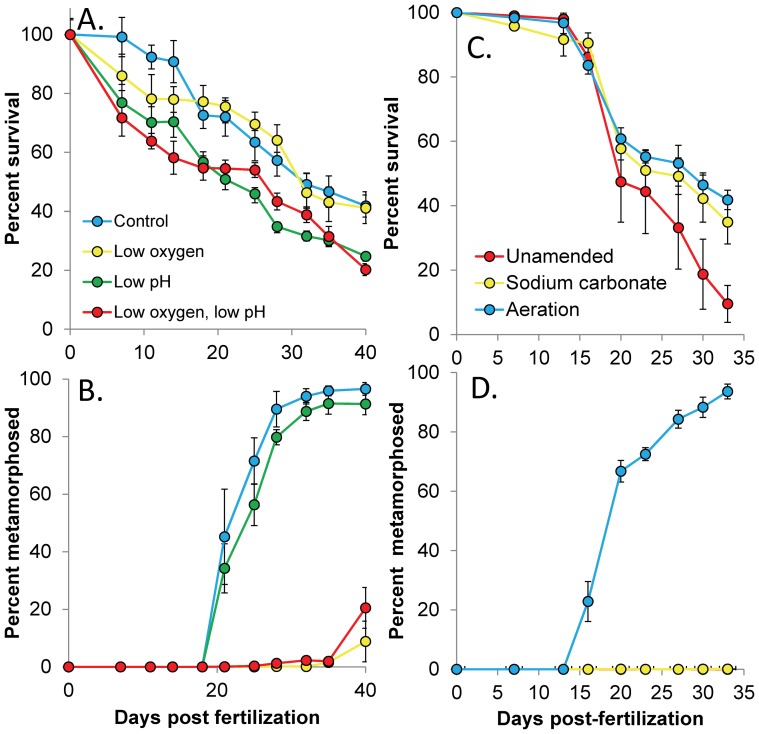
Performance of A. irradians larvae exposed to two levels of dissolved oxygen and pHT.(A) Percent survival and (B) percent metamorphosis of surviving A. irradians larvae during exposure to two levels of pH and dissolved oxygen. (C) Percent survival and (D) percent metamorphosis of surviving A. irradians larvae in water naturally low in dissolved oxygen and pH (umamended), low oxygen with normal low pH (via the addition of sodium carbonate), or with normal oxygen and pH (via aeration with and without sodium carbonate). There was no metamorphosis in the unamended and sodium carbonate treatments. Points are means ±1 S.D. Dissolved oxygen and pH levels are presented in Figures 2. Complete carbonate chemistry is given in Tables S1 and S2, while statistical analyses appear in Tables S5, S6, S8, and S9.